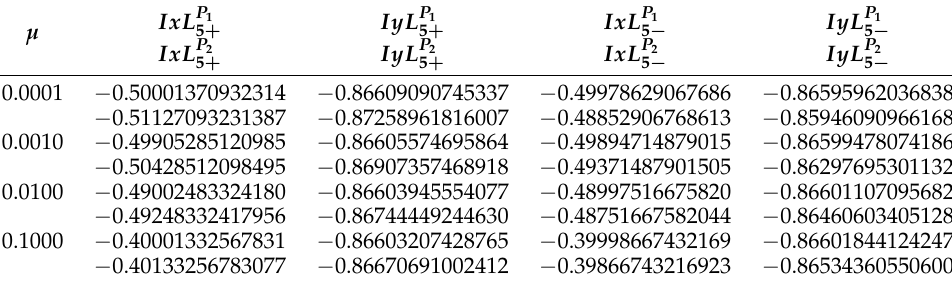
Table 10. The inline equilibrium solution of the restricted 2 + 2 body problem near L 5